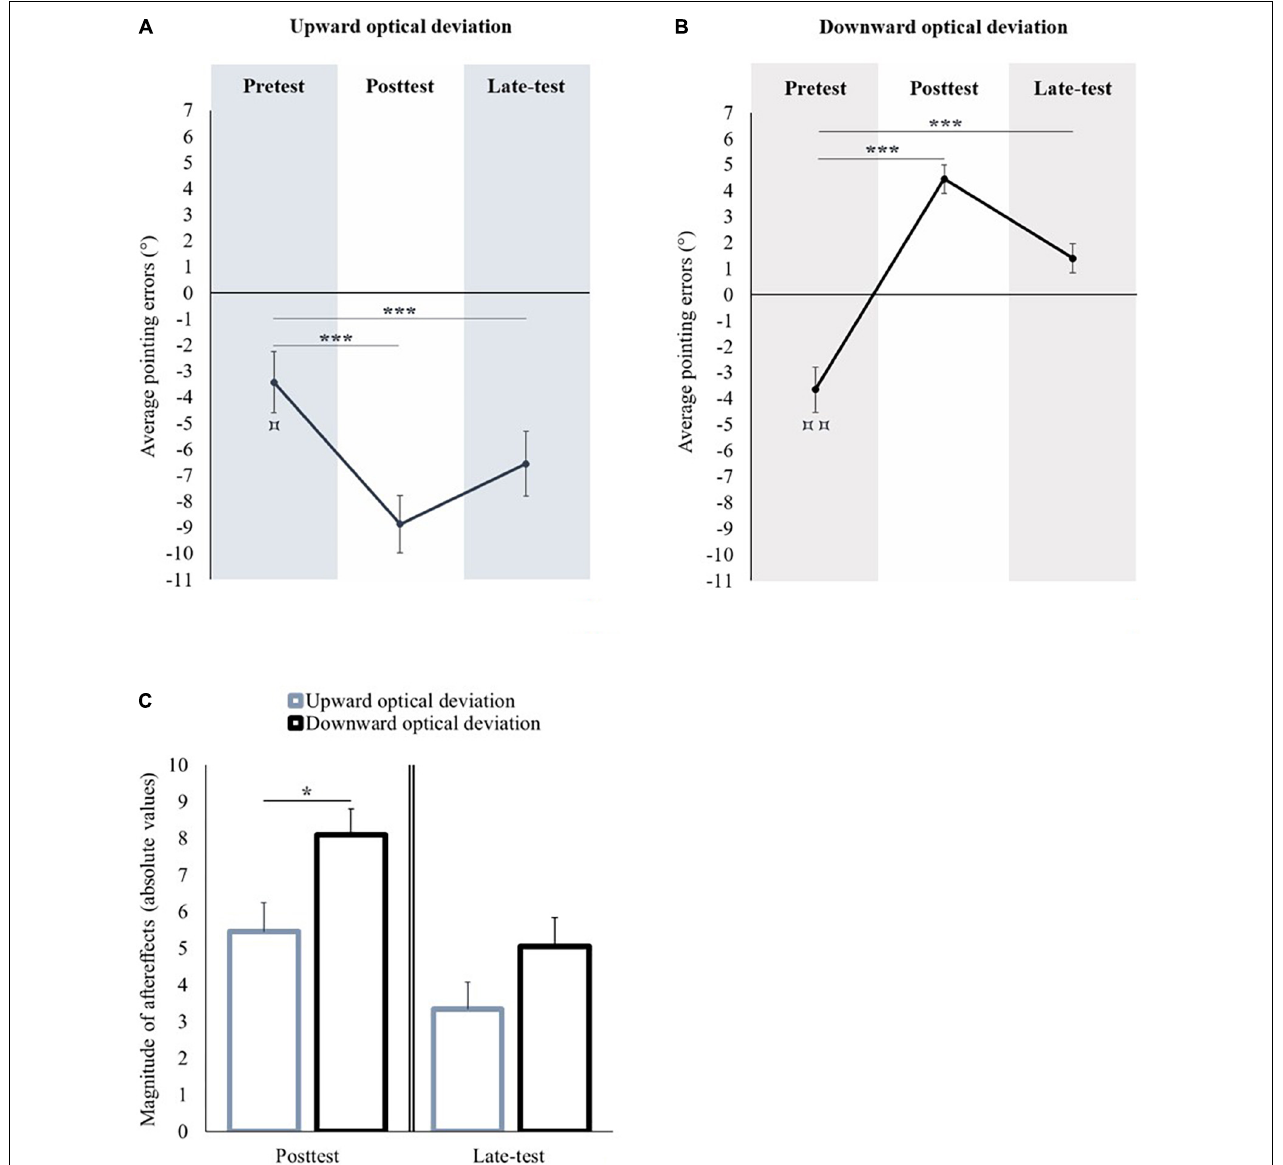
FIGURE 2 | Sensorimotor aftereffects of vertical prism adaptation. Panel (A) displays the sensorimotor aftereffects before (pretest), immediately after (posttest) an upward optical deviation, and at the end of the experiment (late-test). Panel (B) displays the sensorimotor aftereffects before (pretest), immediately after (posttest) a downward optical deviation, and at the end of the experiment (late-test). Panel (C) displays the absolute values of sensorimotor aftereffects occurred following upward and downward prism adaptations in the posttest (left part), and in the late-test (right part). * p < 0.05; *** p < 0.001. Comparison of the pretest to 0: p < 0.05; p < ◊ ◊◊